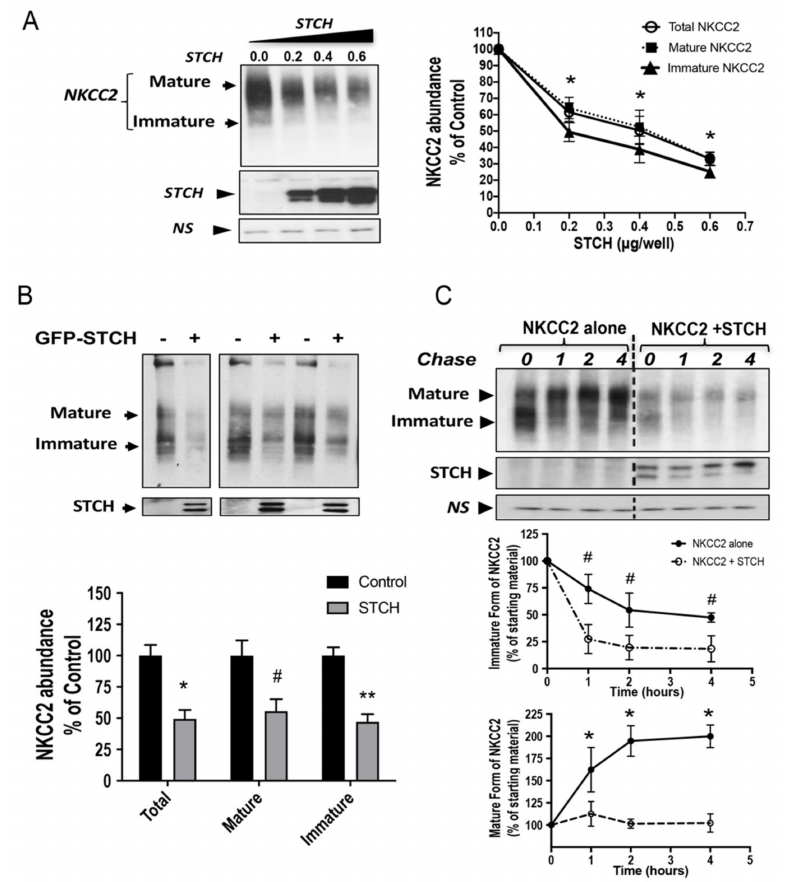
Figure 3. STCH alters NKCC2 stability and maturation. ( A ) Total NKCC2 protein abundance is reduced by STCH in a dose-dependent fashion. HEK cells were co-transfected with Myc-NKCC2 (0.2 µ g/well) and increasing amounts of STCH (0.2–0.6 µ g/well) as indicated. NKCC2 proteins were detected by Western blotting with Myc antibody (left panel). Right panel , densitometric analysis of total, immature, and mature NKCC2 proteins. Data are expressed as a percentage of control. *, p < 0.05 ( n = 3). ( B ) STCH co-expression decreases the expression of NKCC2 proteins. Upper panel , representative immunoblot analysis showing the effect of STCH overexpression on NKCC2 protein abundance in HEK cells. Cells were transfected with Myc-NKCC2 alone (0.2 µ g/well) or in the presence of GFP-STCH (0.6 µ g/well). 16–18 h post-transfection, total cell lysates were subjected to immunoblot analysis for Myc-NKCC2 and anti-GFP. Lower panel , quantitation of steady state mature, immature, and total NKCC2 expression levels with or without STCH co- expression. Data are expressed as a percentage of control ± SE, *, p < 0.04 ( n = 4); #, p < 0.003 ( n = 4); **, p < 0.002 ( n = 4), versus control. ( C ) STCH decreases NKCC2 stability and maturation. Upper panel , representative immunoblot showing cycloheximide chase analysis of NKCC2 in the presence or absence of GFP-STCH. 14–16 h post-transfection, HEK cells transiently expressing WT NKCC2 alone or in combination with STCH, were chased for the indicated time after addition of cycloheximide. Total cell lysates were separated by SDS-PAGE and probed by anti-Myc antibodies. Lower panels, quantitative analysis of NKCC2 stability and maturation. The density of the mature and immature form of NKCC2 proteins was normalized to the density at time 0. #, *; p < 0.05 ( n = 3) versus control. NS , a non-specific band illustrating the equal loading of protein